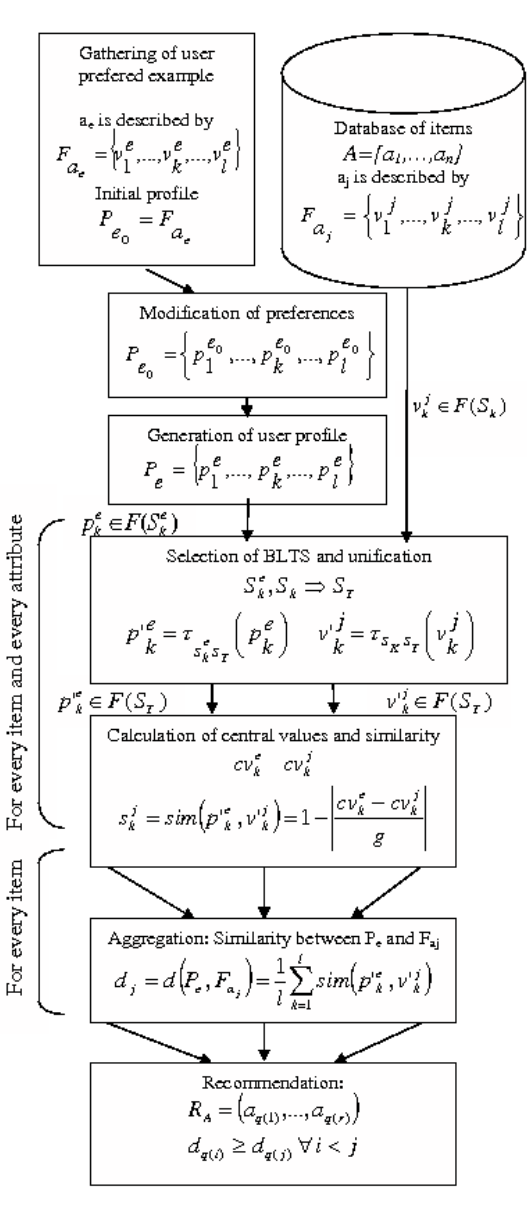
Fig. 4. Recommender System